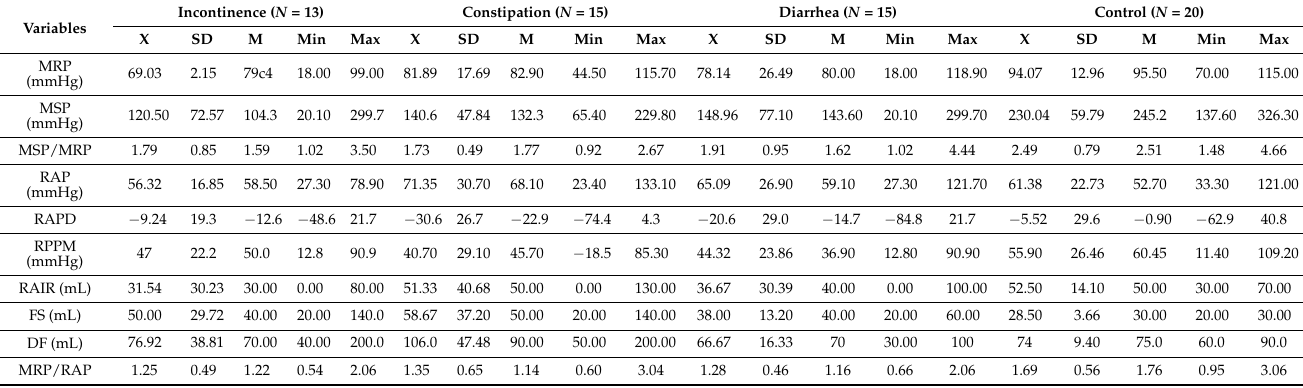
Table 8. Manometric parameters in diabetic patients with selected enteropathy